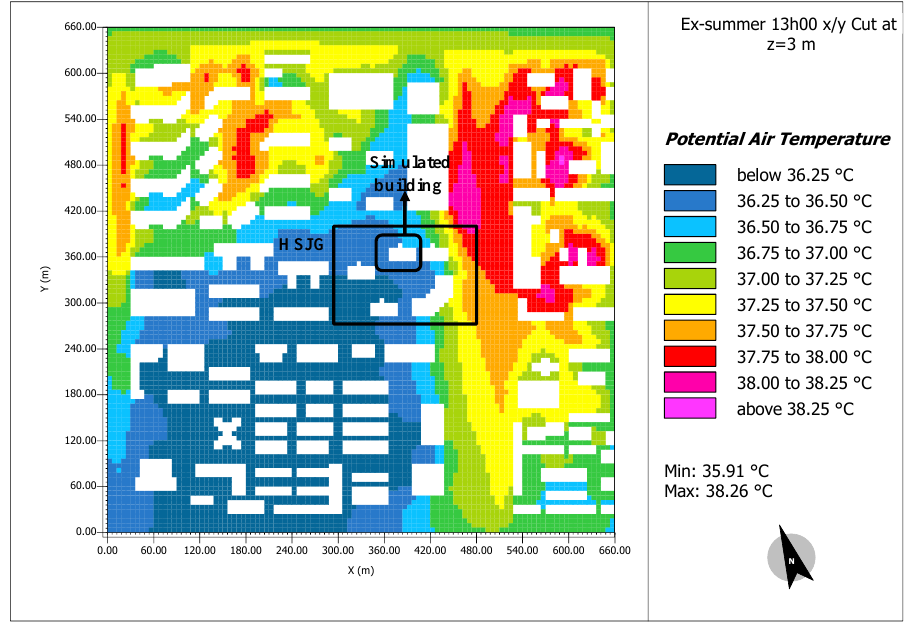
Figure 9. Potential temperature map of the simulated area for ex-summer at the height of 3 m.